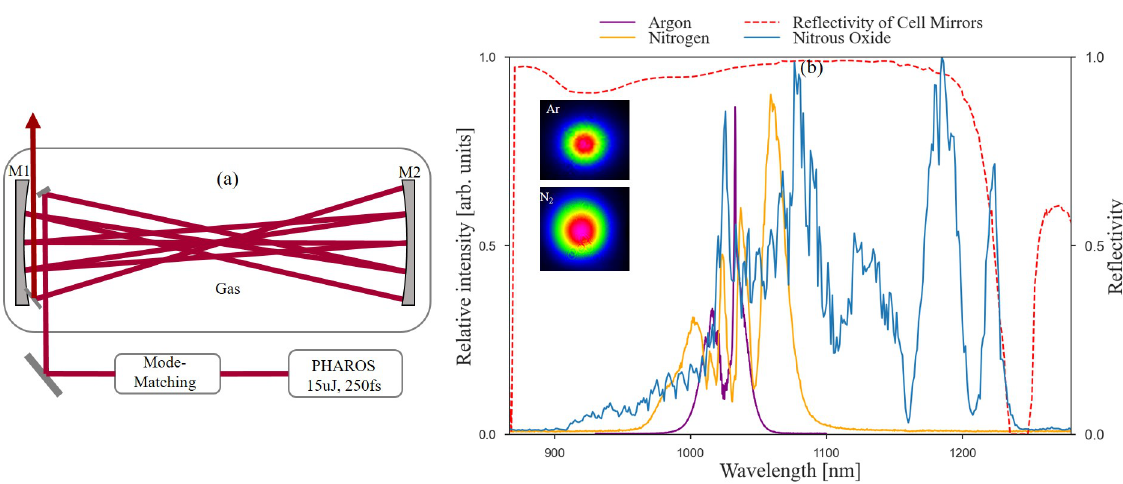
Fig. 1 (a) Schematic of a concave-concave multi-pass cell (MPC). (b) The output spectrum of Ar, N 2 at pulse energy of 15µJ, a repetition rate of 100 kHz and for N 2 O at pulse energy of 15µJ and 10kHz repetition rate inset : output beam profile for Ar and N 2